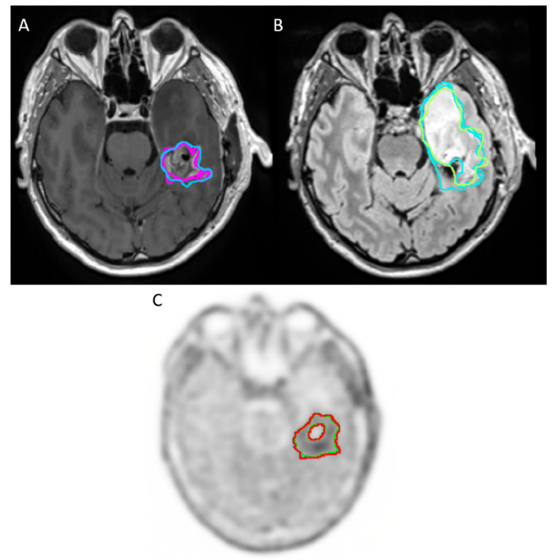
Figure 1. Bland − Altman plot of volumes delineated with 18F-FET PET/CT, T1-GD, and FLAIR se- quences. T1-GD and 18F-FET PET/CT volumes are the most similar. T2-FLAIR and T1-GD and T2- FLAIR and 18F-FET volumes PET/CT are the most similar for small volumes, but show higher dif- ferences for high volumes. Figures 2 and 3 show examples of volumes delineated with the different sequences.